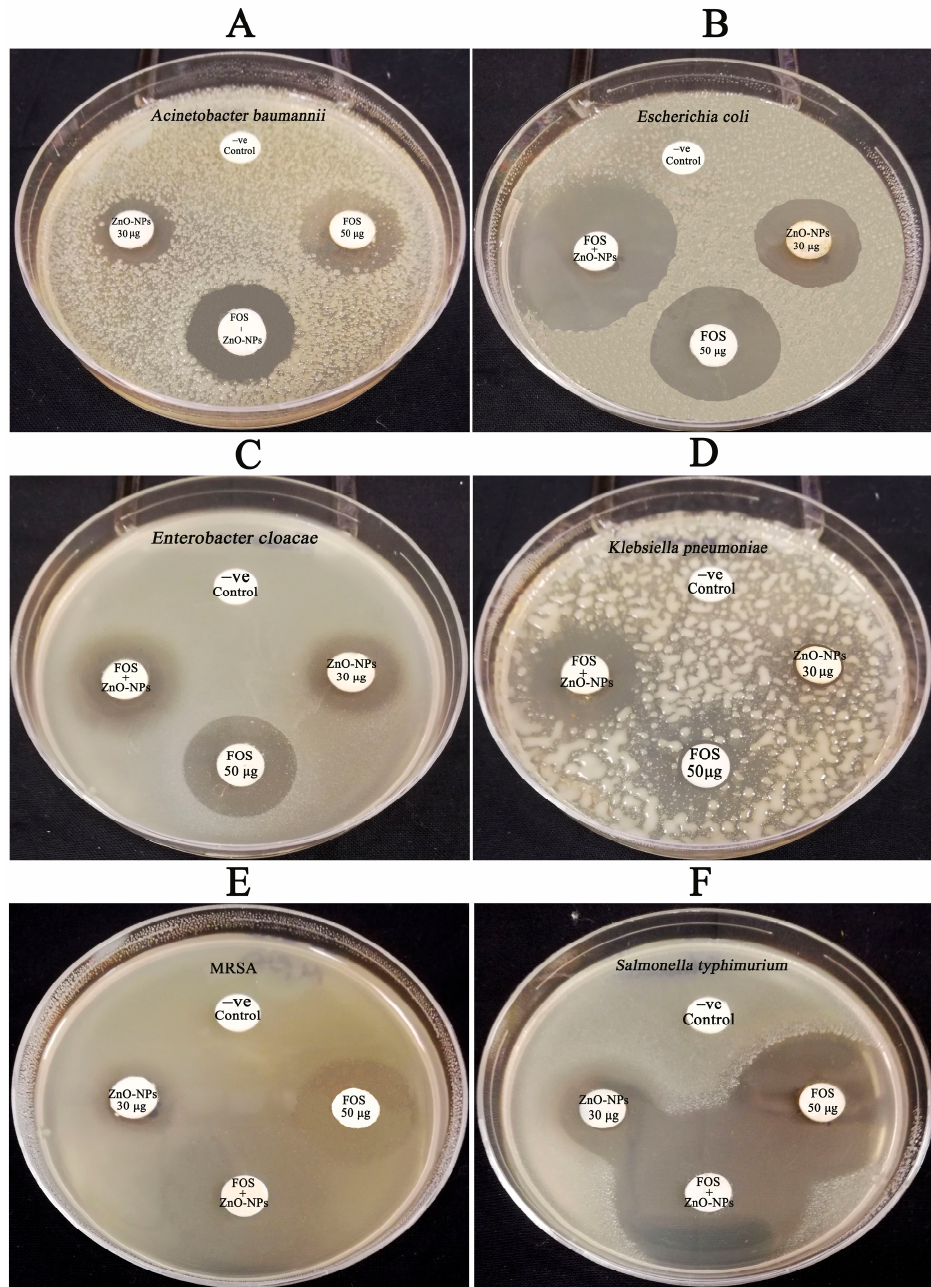
Figure 13. Synergistic patterns of ZnO-NPs with fosfomycin against bacterial pathogens. (A) A. baumannii , (B) E. coli , (C) E. cloacae , (D) K. pneumoniae , (E) MRSA, (F) S. typhimurium .